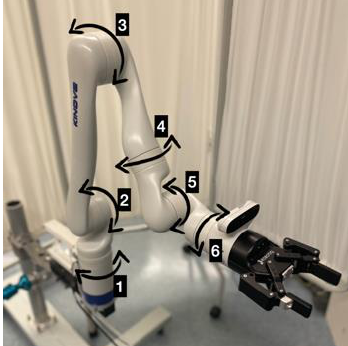
Figure 1. The robot with joints labelled (1-6) and arrows showing rotation for each of the six joints.